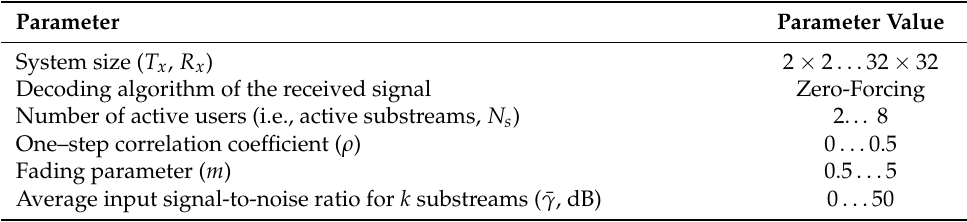
Table 1. System and channel parameters assumed for the simulation. Parameter